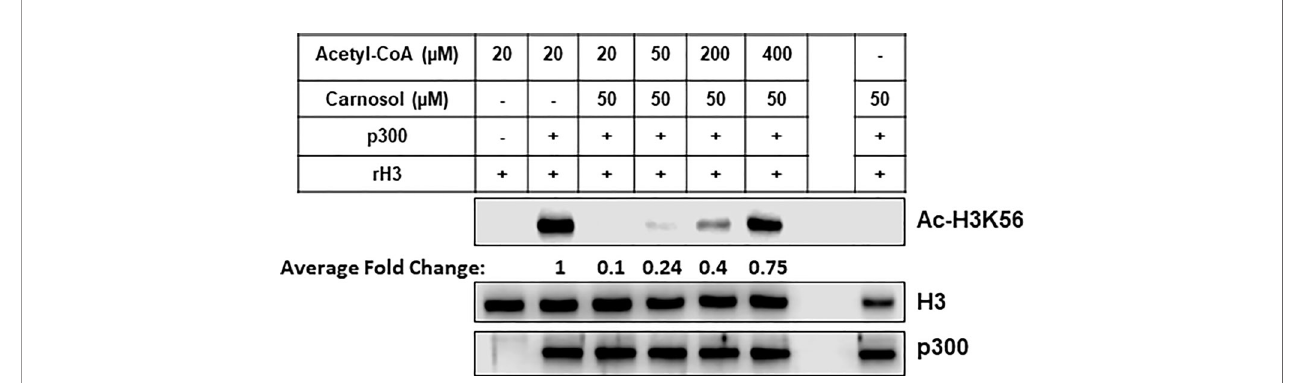
FIGURE 8 | Carnosol competes with acetyl-CoA to bind to the p300 catalytic domain. Recombinant p300 catalytic domain (aa 1,284 – 1,673) was incubated with recombinant histone H3 and increasing concentrations of acetyl-CoA in presence of 50 µM carnosol. Histone acetylation was monitored by Western blotting scoring of acetylated H3K56. Data shown for all HAT assays are representative of three independent experiments. The intensities of the bands were quanti fi ed using the ImageJ software (National Institute of Health,